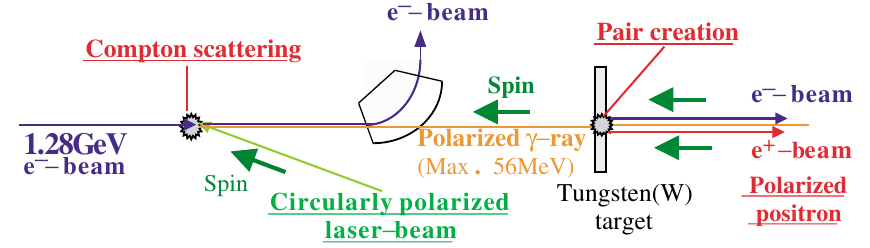
FIG. 1. (Color) Concept of polarized positron generation. The circularly polarized laser beam is backscattered on the electron beam and generates polarized (cid:1) rays, which successively pair create polarized